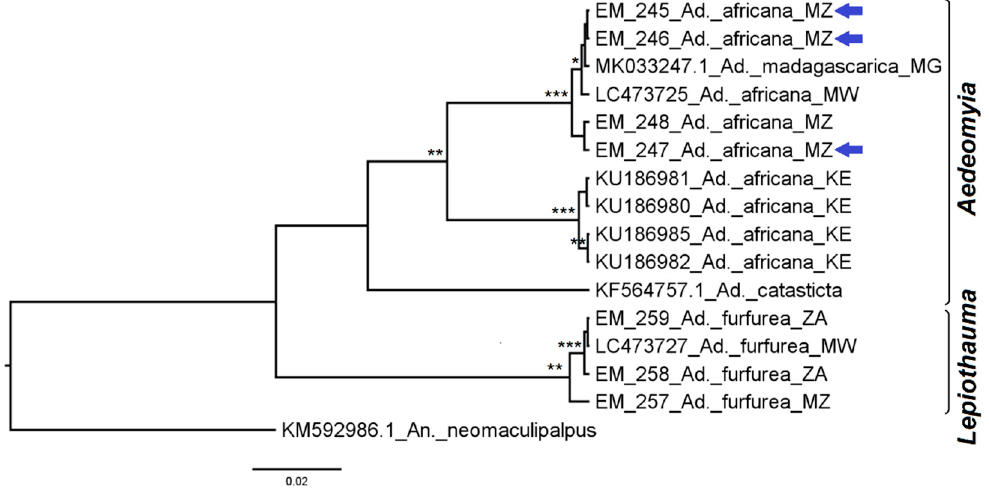
Figure 2. Phylogenetic analysis of 15 partial coxI nucleotide sequences from Aedeomyia mosquitoes. At specific branches, the number of * indicates the tree topological support revealed by the different phylogenetic reconstruction methods, assuming relevant bootstrap and aLRT values above 75% and posterior probability values above 0.80. The sequences obtained in this work are designated with the “EM” code, while those with associated genitalia are indicated with horizontal blue arrows. Reference sequences downloaded from the public databases are shown by their respective access codes (Boldsystems) or accession numbers (GenBank), as well as the country of origin [South Africa (ZA), Madagascar (MG), Malawi (MW), Mozambique (MZ), Kenya (KE)]. Vertical lines mark the Aedeomyia and Lepiothauma subgenera.